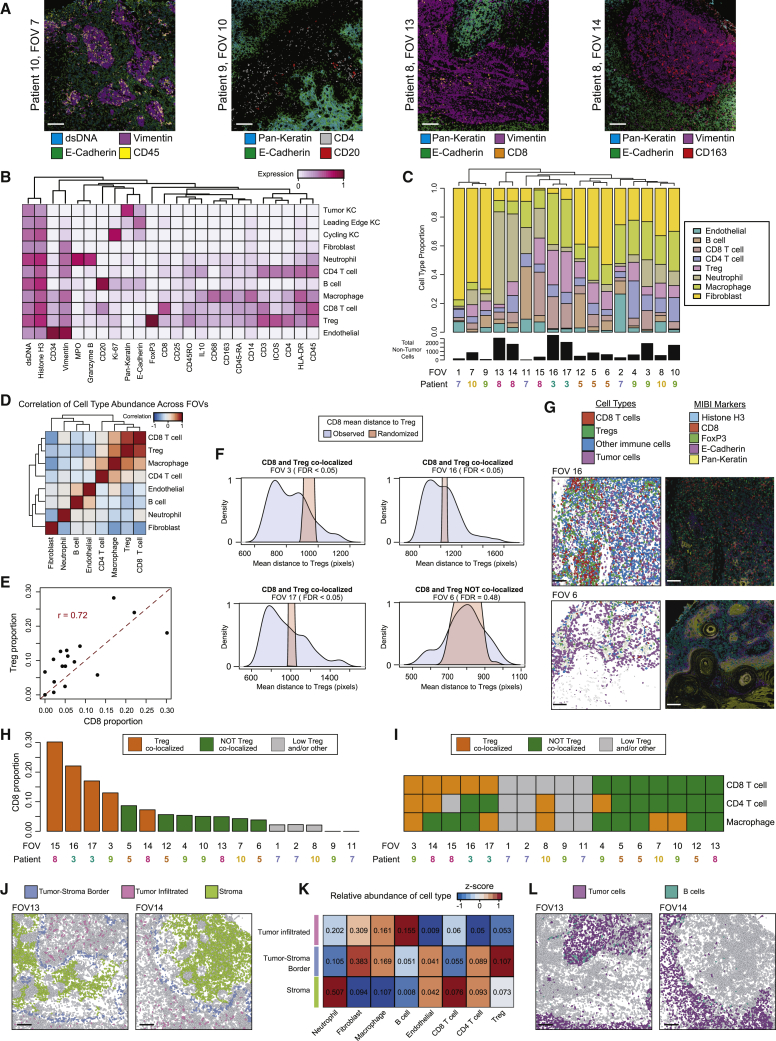
Spatial Architecture of Lymphocyte Subsets in cSCC(A) Select MIBI fields of view (FOVs) for patient samples with expression of highlighted features.(B) Heatmap of feature expression across cell types identified by MIBI.(C) Top, bar plots of proportion of non-tumor cell types across all FOVs. Bottom, bar plots of total numbers of non-tumor cells identified in each FOV.(D) Correlation heatmap of non-tumor cell types across all FOVs.(E) Scatterplot and correlation of CD8 T cell and regulatory T cell (Treg) correlation across FOVs.(F) Density plots of CD8 T cell distance to Tregs across four FOVs, demonstrating variation in CD8 to Treg co-localization. FDR, false discovery rate by permutation (STAR Methods).(G) Expression of Treg marker FoxP3, CD8, and tumor cell markers E-cadherin and pan-keratin.(H) Ranked bar plots of CD8 proportion in each FOV labeled by co-localization pattern with Tregs.(I) Co-localization patterns of Tregs and either CD4, CD8, or macrophages.(J) Non-tumor cells flagged by location relative to tumor and stromal compartments.(K) Heatmap of relative abundance of cell types in each compartment. Values represent proportion of total non-tumor cells in compartment contributed by each cell type.(L) B cells infiltrate tumor parenchyma in select FOVs. All FOVs in figure are 800 × 800 μm.All scale bars, 100 μm. See also Figure S5 and Table S5.